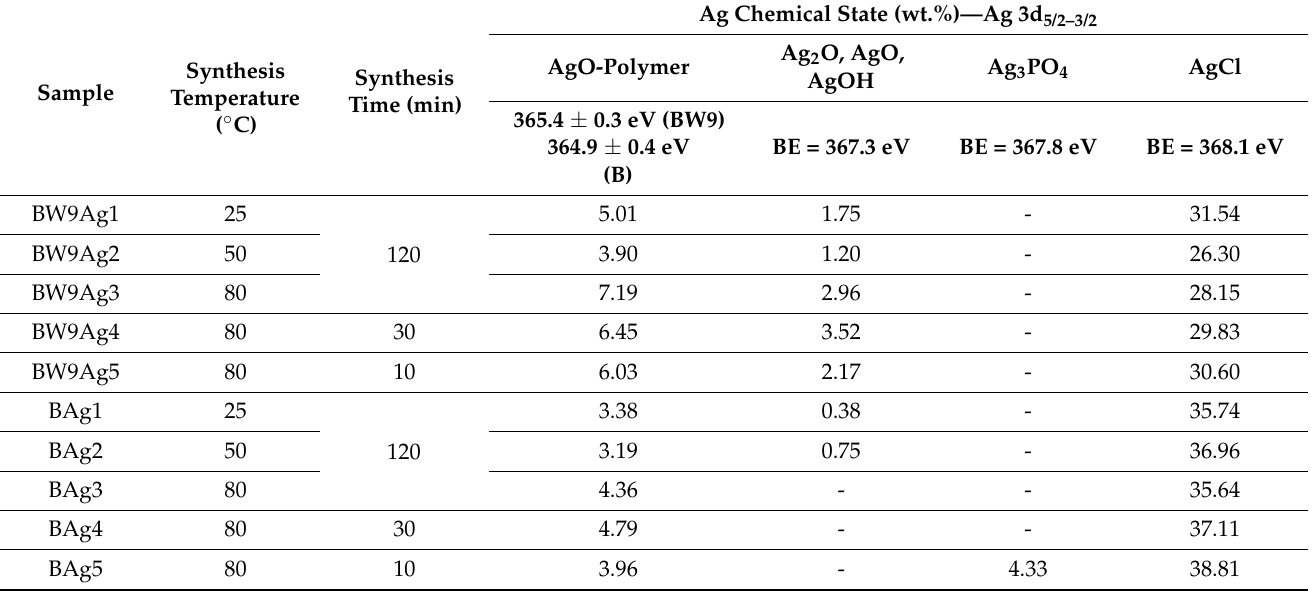
Table 5. Surface Ag chemical state content in BW9 and B nanocomposites obtained from XPS